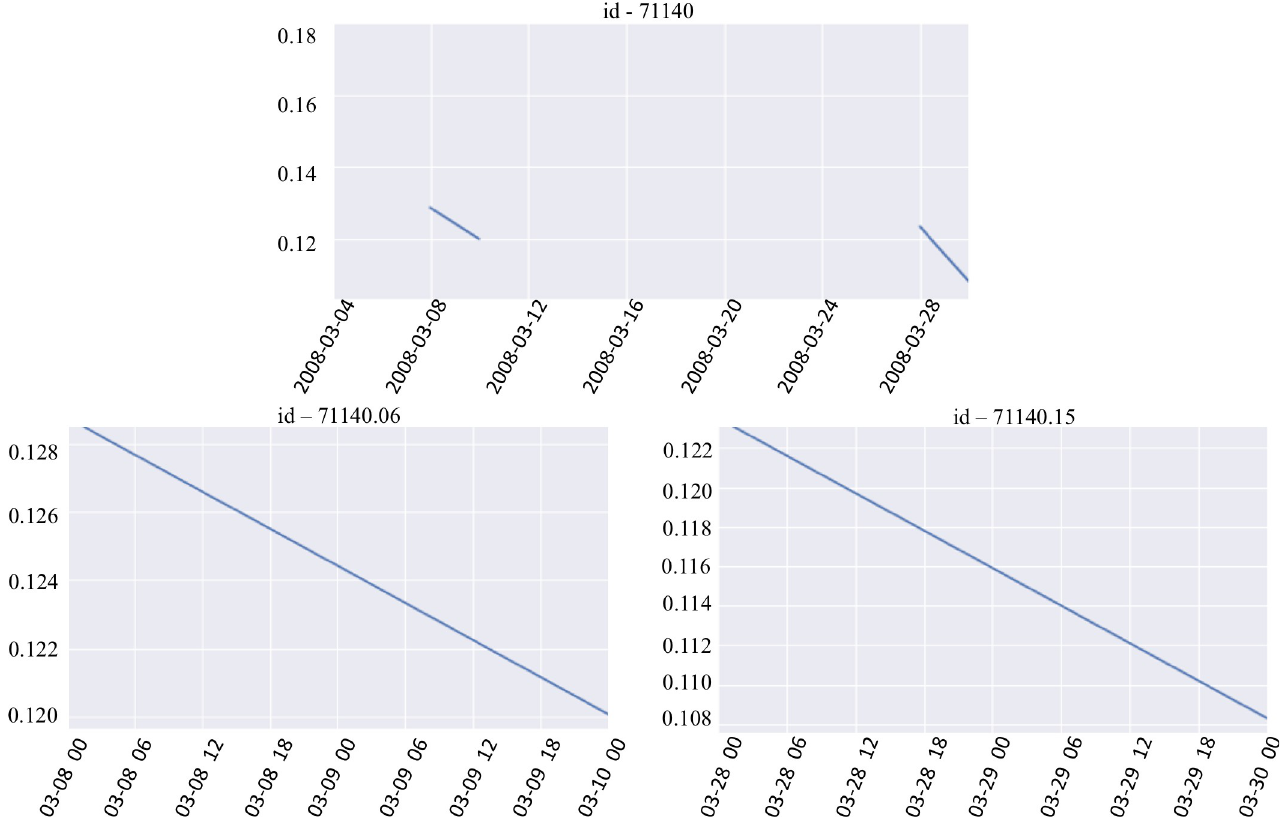
Fig 6. The time series of ‘chlor_a’ from the float 71140 on the top panel is split into 5 different shorter series. Three series of length 1 are dropped, and the remaining two are shown on the bottom panel.